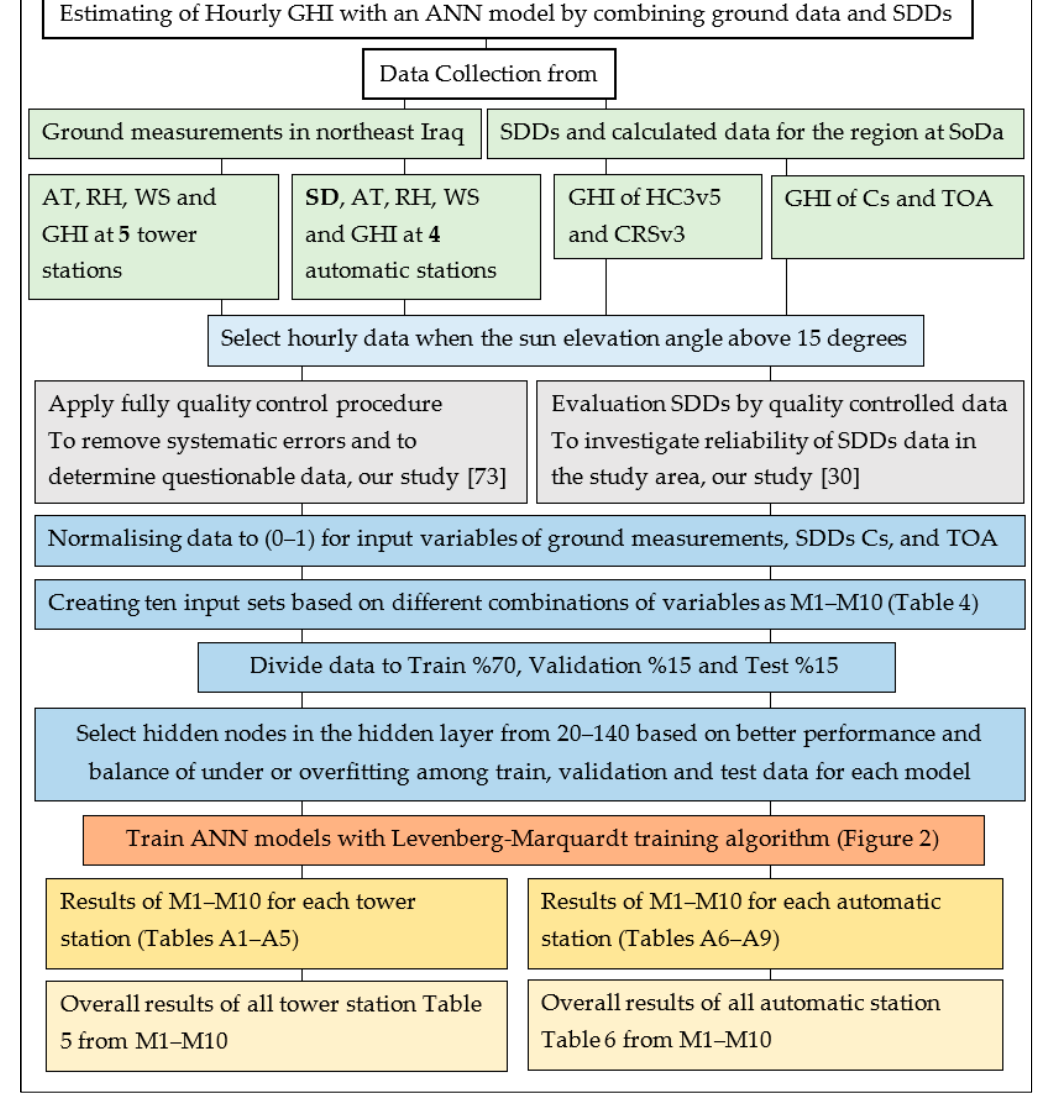
Figure 3. Flowchart of the methodology steps.